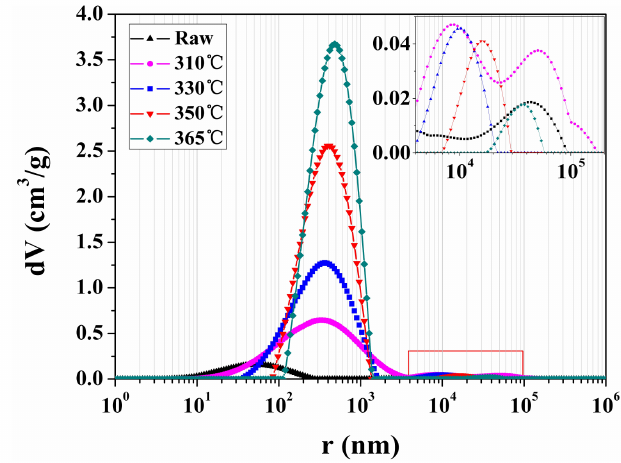
Figure 11. PSD of the raw and spent samples extracted by sub-critical water for 150 h at different temperatures. The inset figure is the local enlarged drawing of curves in the red